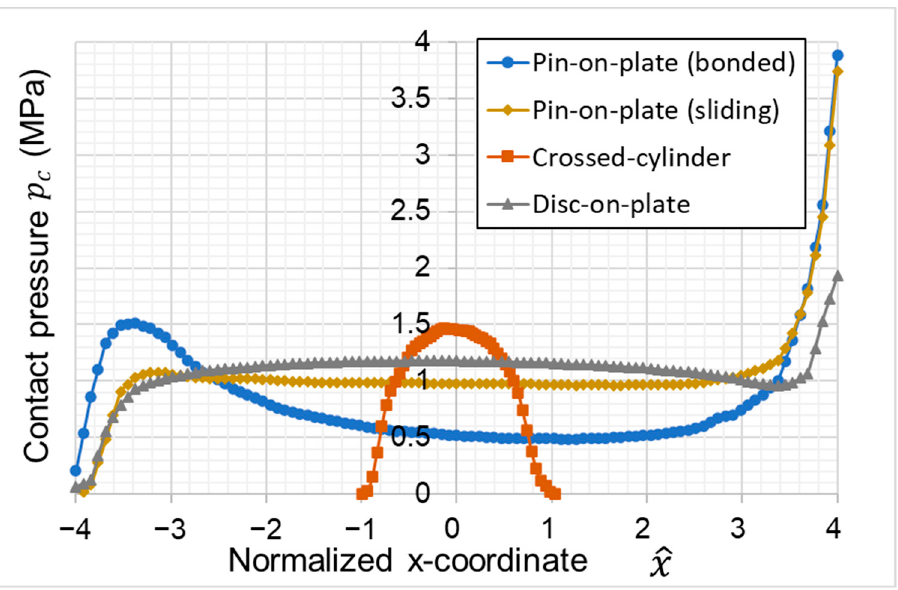
Figure 3. Comparison between contact pressure distributions for different test setup configurations.